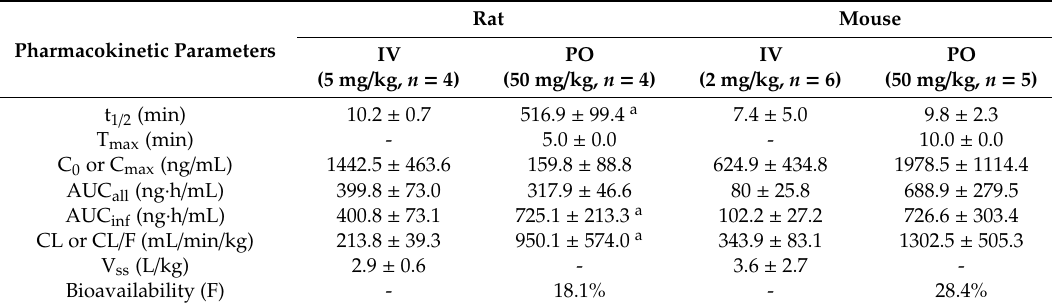
Figure 3. Average plasma concentration vs. time profiles of desoxo-narchinol A after (A) intravenous administration at a dose of 5 mg/kg ( n = 4) and (B) oral administration at a dose of 50 mg/kg ( n = 4) in rats. Data represent the mean ± SD. Table 5. Non-compartmental pharmacokinetic parameters of desoxo-narchinol A following intravenous injection (IV) or oral administration (PO) in rats and mice.